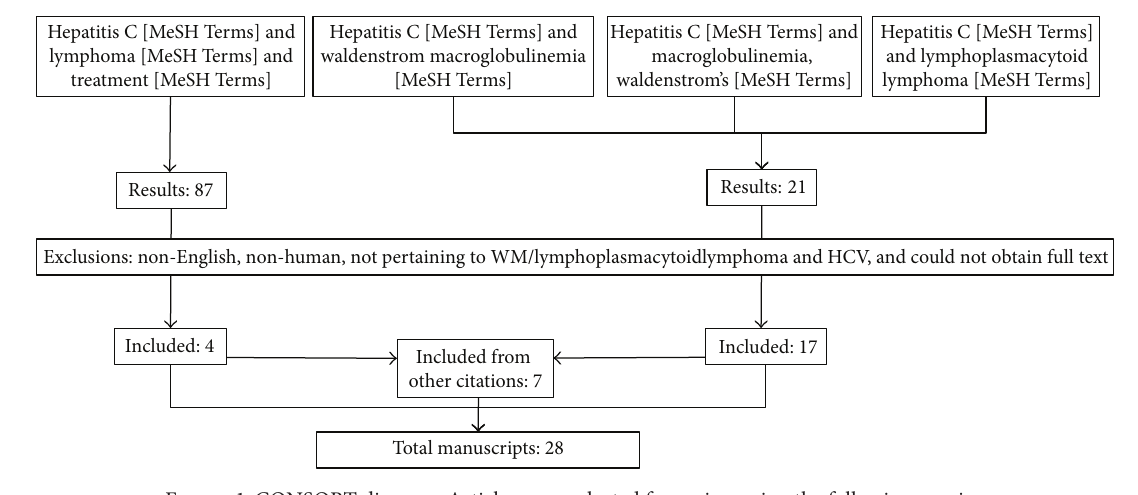
Figure 1: CONSORT diagram. Articles were selected for review using the following